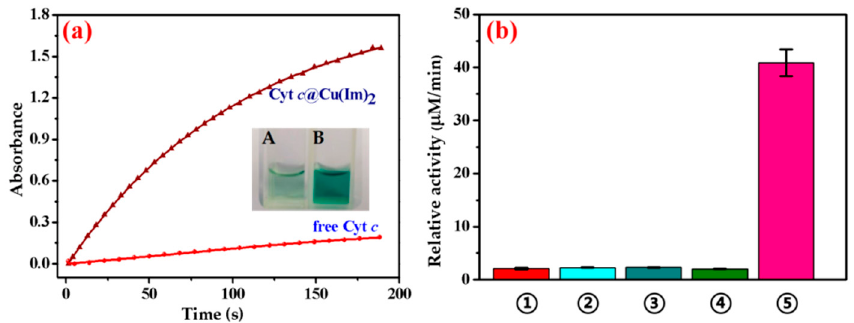
Figure 3. High resolution microscope image of ( a ) GOx@Cu(Im) 2 − RhB, ( b ) Cyt c @Cu(Im) 2 − FITC and ( c ) GOx − RhB and Cyt c − FITC@Cu(Im) 2 (scale bar is 15 µm).